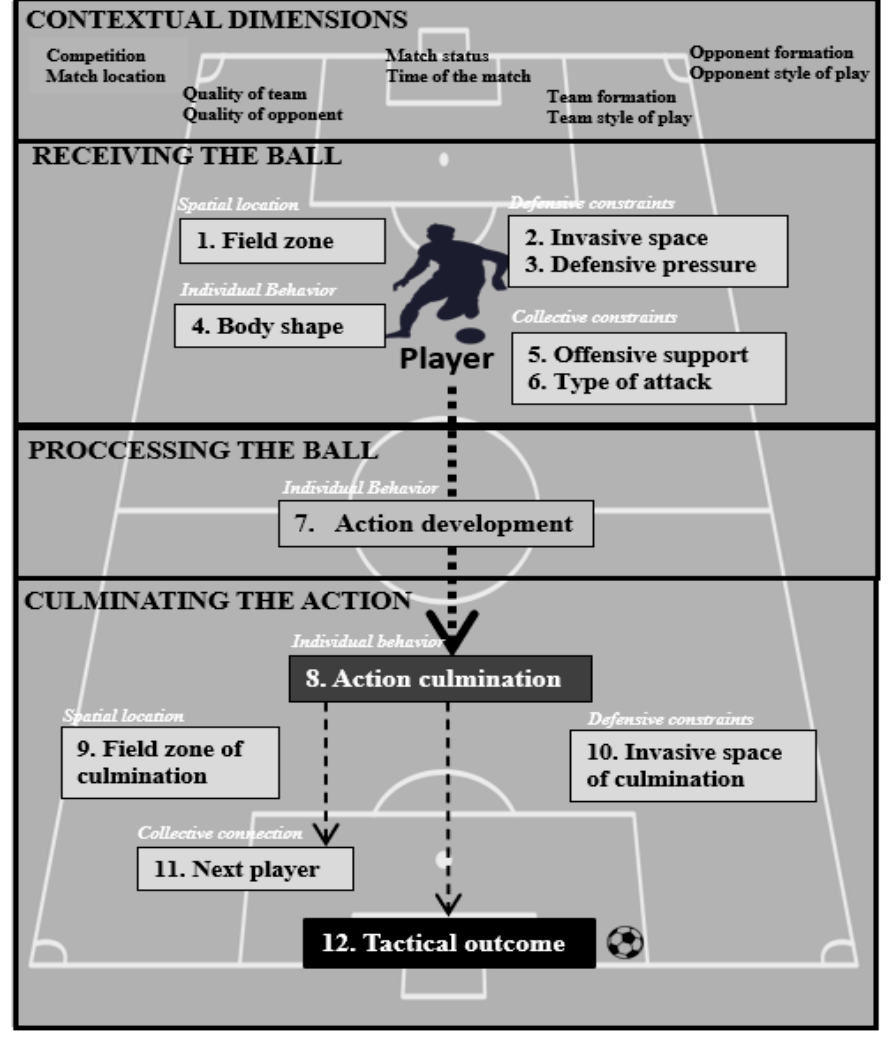
Figure 1. Scheme of the macro-criteria, temporal moments, and dimensions of the INDISOC tool.